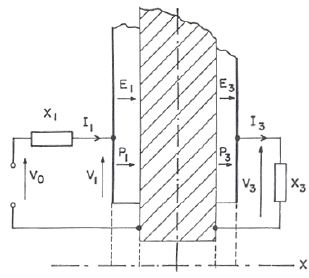
Figure 12. Thickness mode transformer suggested by Othmar M. Stuetzer, Sandia Labs, in 1966 [60].